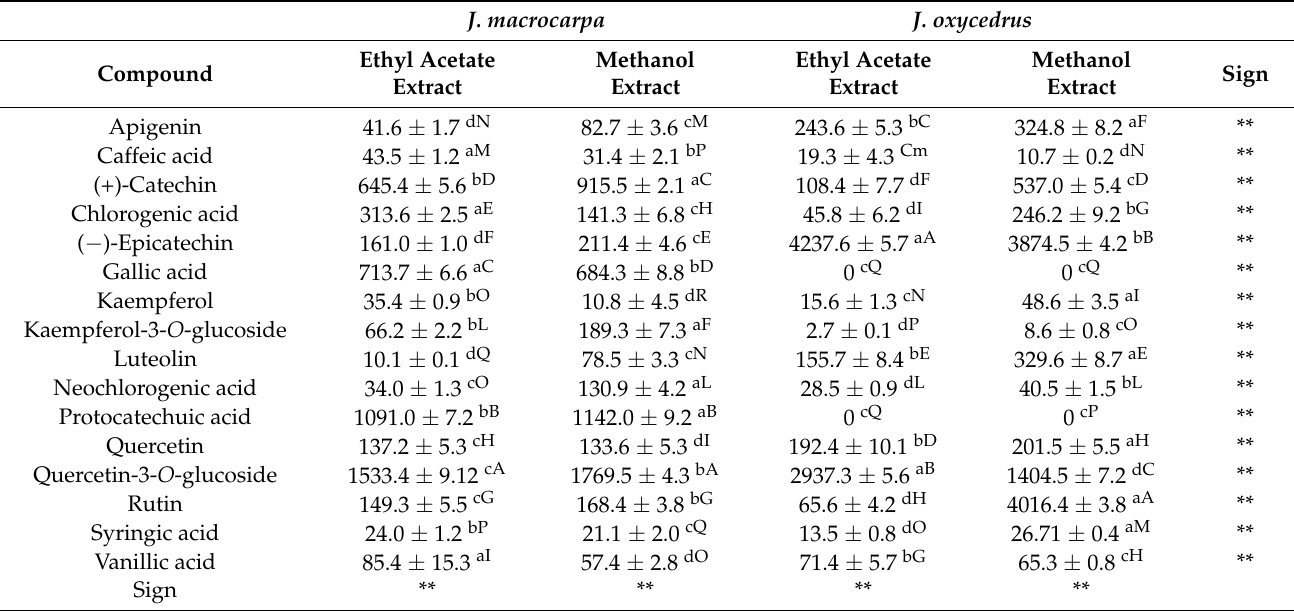
Table 2. HPLC-DAD profiles ( µ g/g) of J. macrocarpa and J. oxycedrus polar